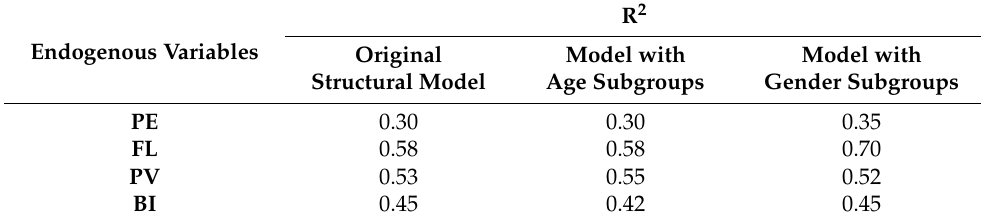
Table 6. R 2 values of endogenous variables in different